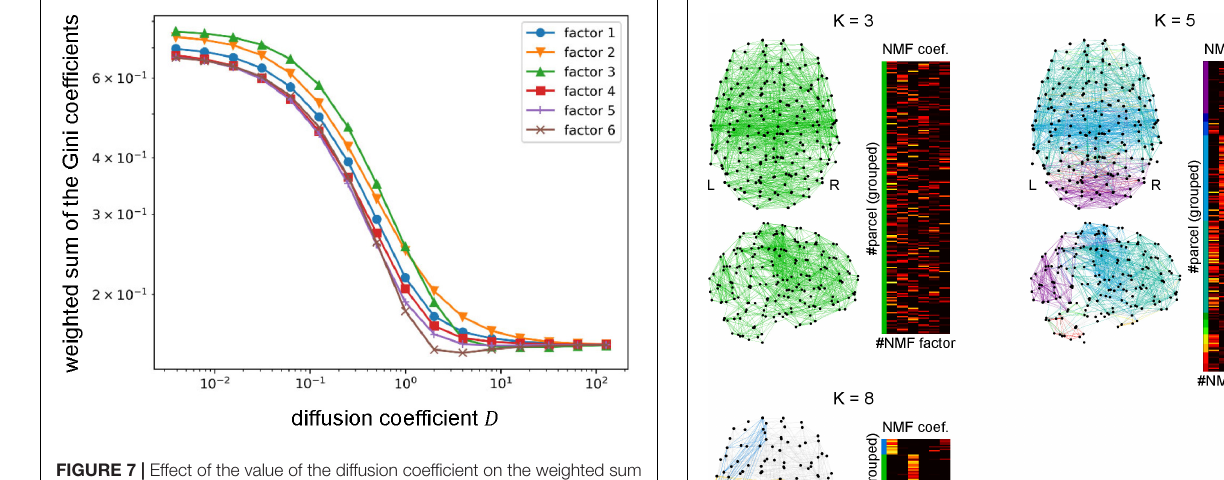
FIGURE 7 | Effect of the value of the diffusion coefficient on the weighted sum of the Gini coefficient. Log-log plots of the weighted sums of Gini coefficients with varying the diffusion coefficient. Throughout the parameter region, relative orders are qualitatively similar except for the factor 3. The weighted sum of Gini coefficients for factor 3 moves from largest (i.e., lowest diversity of informational interaction) to smallest (i.e., highest diversity of informational interaction).